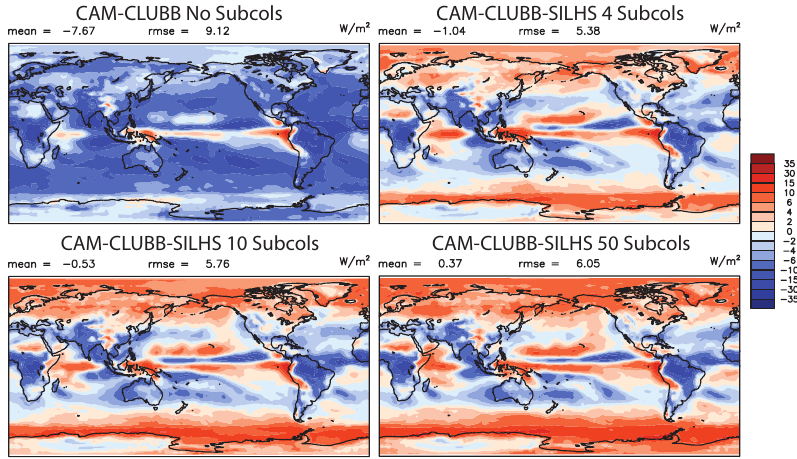
Figure 12. LWCF difference from CERES-EBAF observations for 5 years of simulation without subcolumns at all (top left), 4 subcolumns (top right), 10 subcolumns (bottom left), and 50 subcolumns (bottom right). Without subcolumns, the LWCF has a severe low bias. The simulation with 4 subcolumns has the lowest global error, and very little changes between the simulations with 10 and 50 subcolumns.